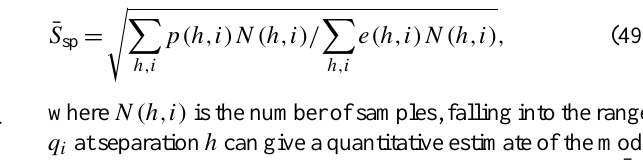
Fig. 7. The spatial variability prediction statistics S sp (h,i) (Eq. 48), as a function of gauge separation distance h =0.88, 1.75, 2.64, ..., Figure 7. The spatial variability prediction statistics ( ) ihS 10.51km, at rainfall intensity ranges q i , i = 1,..., N q , 1t separation distance h =0.88, 1.75, 2.64, ..., 10.51 km, at rainfall intensity ranges N , ∆ t = 1 minute. 5 q 6